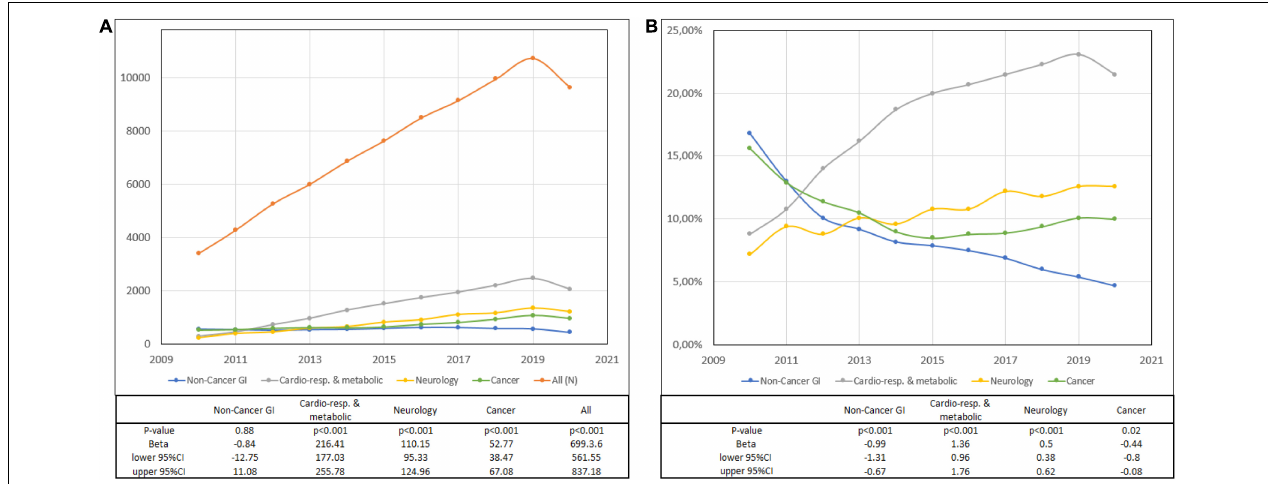
FIGURE 1 | Primary diagnosis and trends. (A) Number of percutaneous endoscopic gastrostomies (PEGs) and (B) the percentage of PEGs with a primary diagnosis.